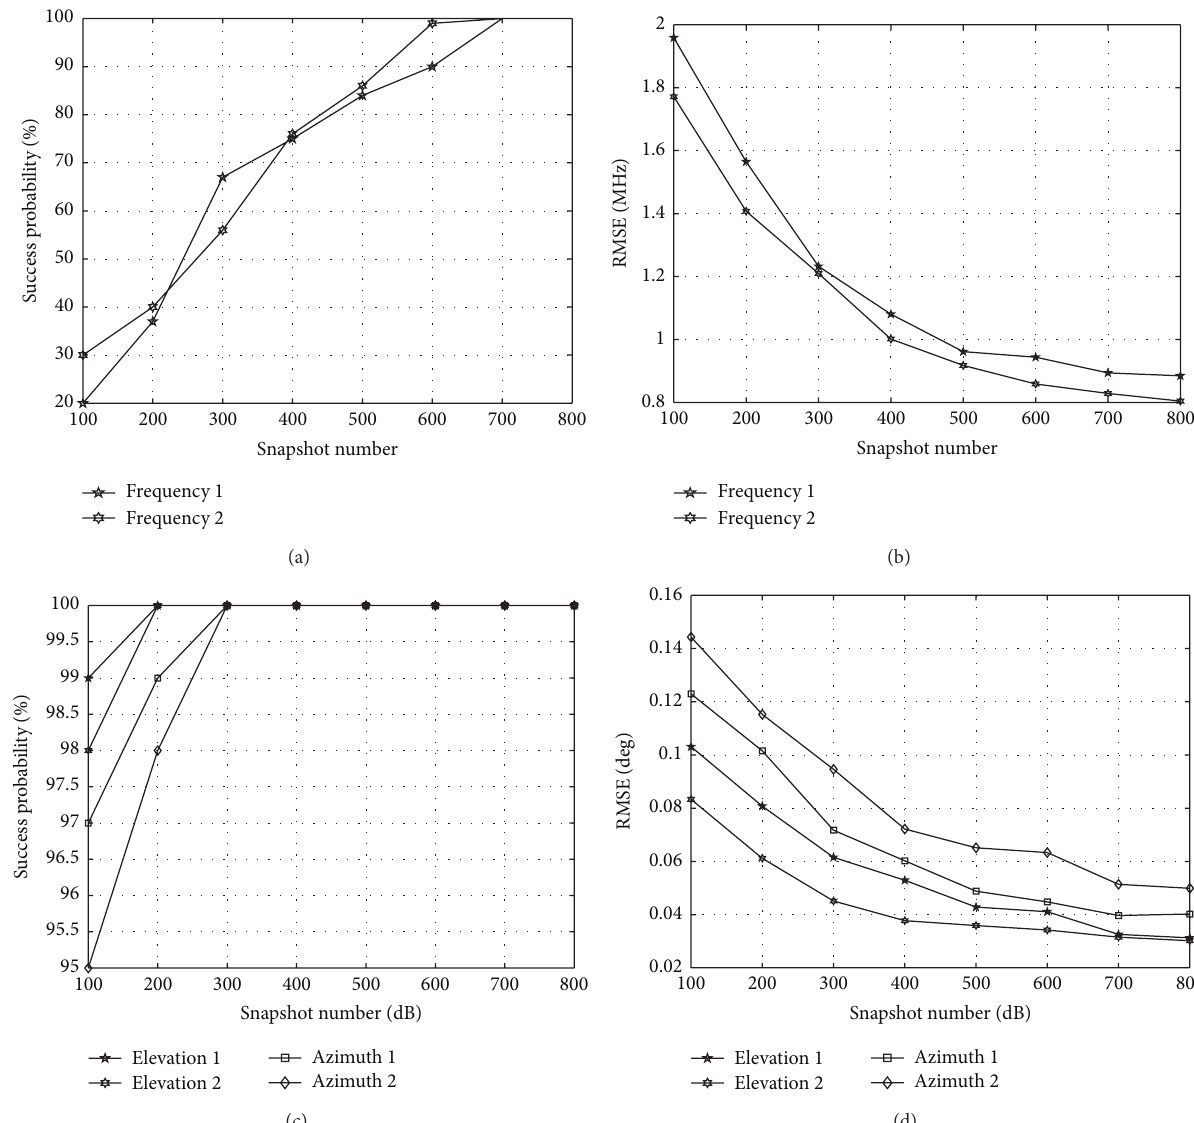
Figure 4: The RMSE and successful probability with different snapshot number. (a) The successful probability of frequencies, (b) the RMSE of frequency, (c) the successful probability of angles, and (d) the RMSE of